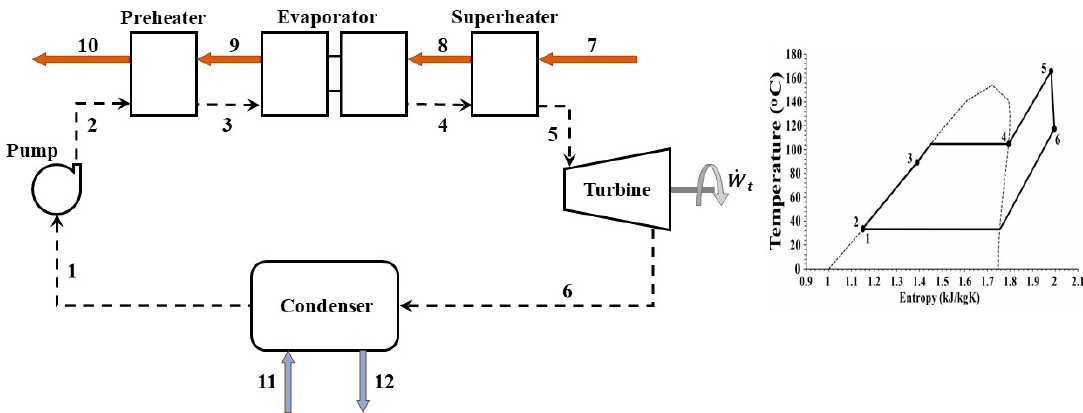
Figure 2. The schematic representation and temperature-entropy change diagram of the ORC.